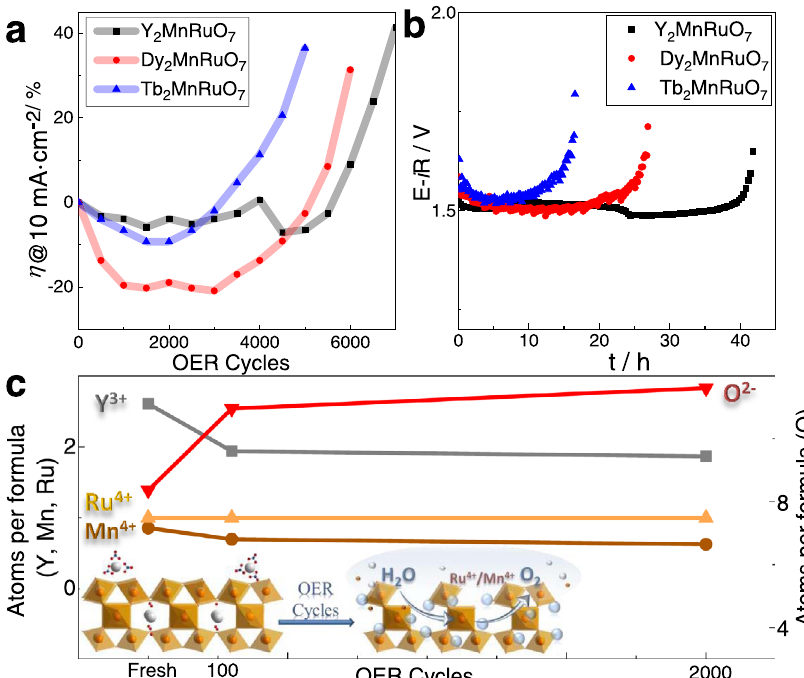
Fig. 3 | DurabilityofR 2 MnRuO 7 pyrochloresunderOER conditions.a Evolution of the potential at 10mAcm − 2 during OER cycles measured between 1.2 and 1.7V at 50mVs − 1 . b Chronopotentiometry measurements at a current density of 10mAcm − 2 . c Surface composition of Y 2 MnRuO 7 pyrochlore: initial catalyst, after 100 OER cycles and after 2000 OER cycles (data from Table S4). Lower inset: